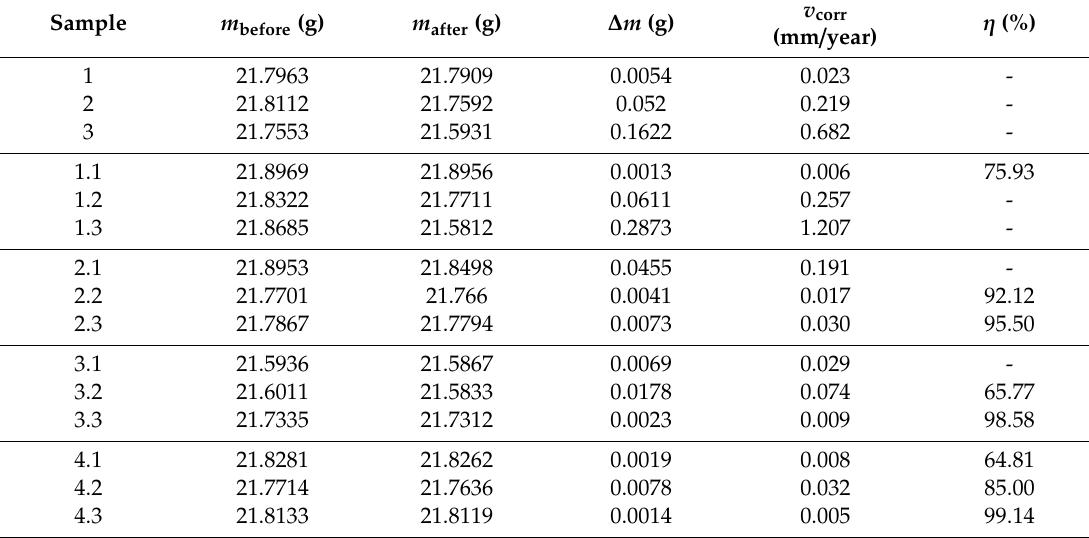
Table 2 . Gravimetric test results before and after treatment in aqueous solutions .